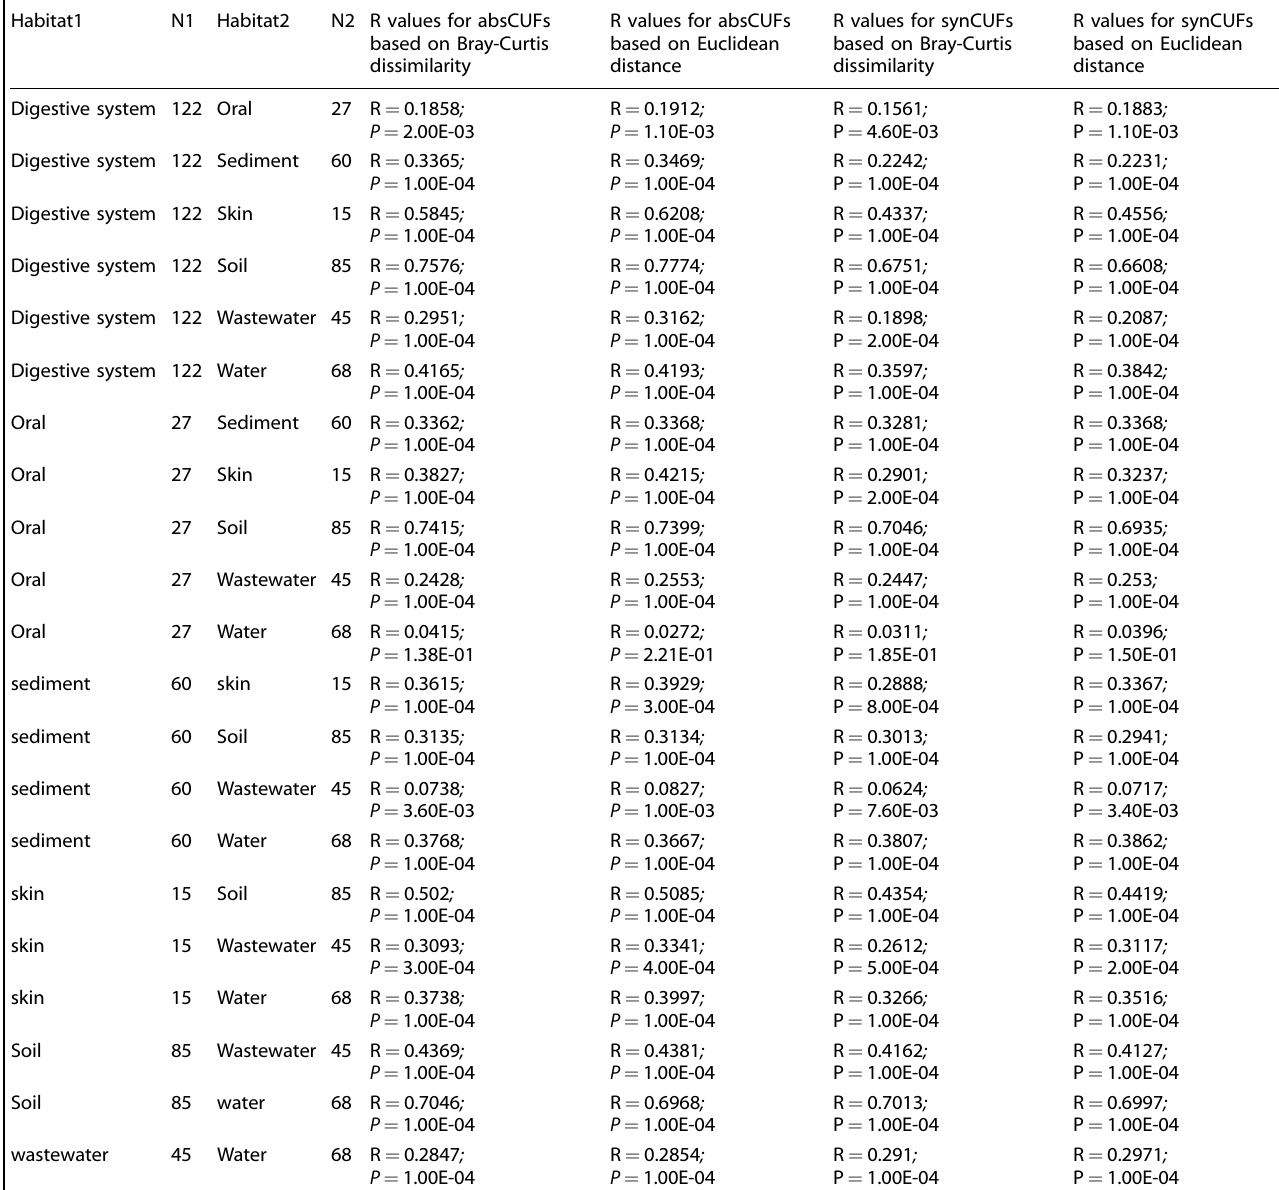
Table 1. ANOSIM results for codon usage distance comparisons among the samples from seven selected habitats.